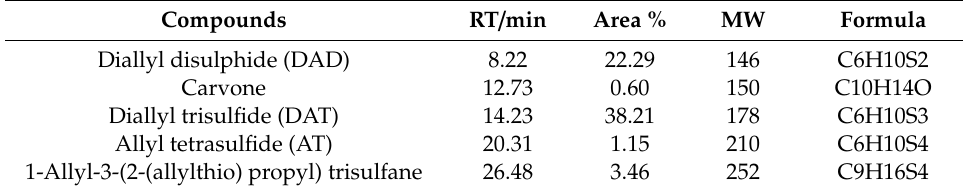
Figure 2. The spectrum of identified compounds from Allium sativum powder by using Trace GC1300-TSQ mass. Table 1. Phytochemical contents of Allium sativum